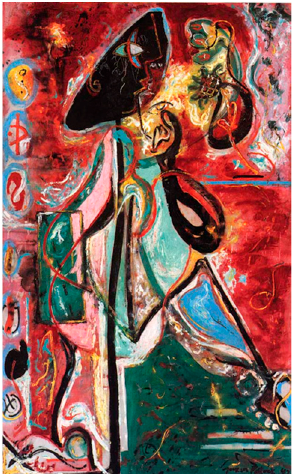
Figure 9. Jackson Pollock, The Moon Woman , 1942, oil on canvas, 69 × 43 in. (175.2 × 109.3 cm). Peggy Guggenheim Collection, Venice (The Solomon R. Guggenheim Foundation). © 2022 The Pollock-Krasner Foundation/Artists Rights Society (ARS), New York.